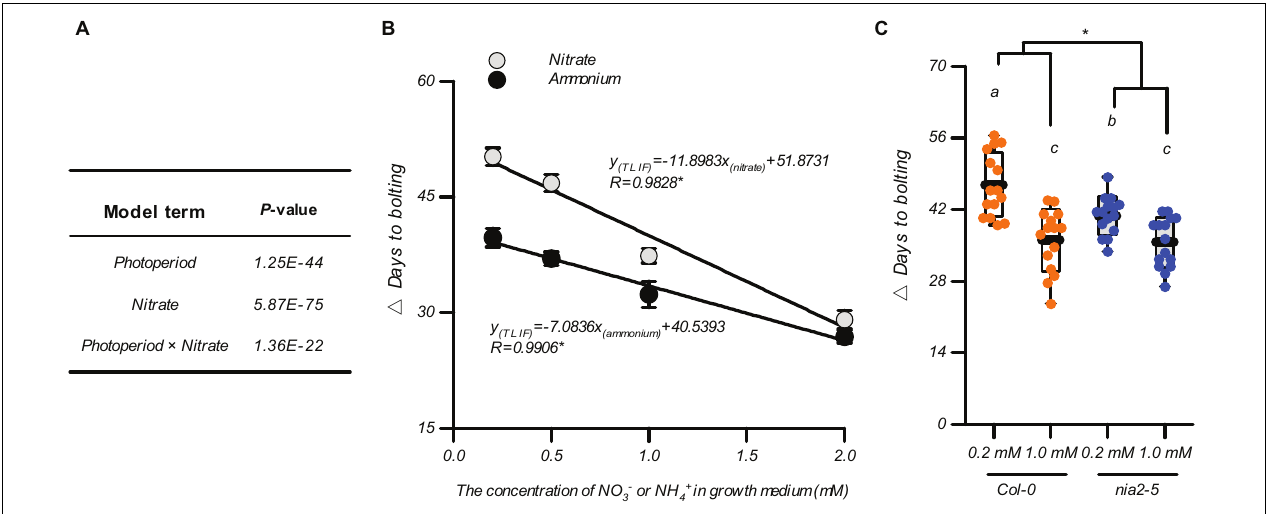
FIGURE 2 | Association of flowering under LD conditions with nitrate availability. (A) Statistical analysis of the data from Figures 1A,C . Data were analyzed using a two-way ANOVA followed by Duncan’s multiple range test. (B) The time of LD-induced flowering ( (cid:77) days to bolting) in the Col-0 plants grown with different nitrogen sources. Different concentrations of (NH 4 ) 2 SO 4 including 0.2, 0.5, 1.0, and 2.0 mM were used to replace the KNO 3 in the agar medium. (C) The time of LD-induced flowering ( (cid:77) days to flowering) in the Col-0 plants and nia2-5 mutants, grown with 0.2 mM or 1 mM nitrate. Seedlings were grown on agar media containing nitrate or ammonium as indicated. The potassium concentrations in all growth media were adjusted to 1 mM using K 2 SO 4 . LD: 16-h light/8-h dark; SD: 8-h light/16-h dark. (cid:77) Days to bolting was calculated by subtracting the bolting time of plants grown under LD conditions from that of plants grown under SD conditions, with the same nitrogen treatment. Raw data of panels (B,C) from individual photoperiods are shown in Supplementary Figures 6, 7 . At least 20 plants grown in each of the LD and SD conditions were used for the quantification of flowering. Error bars represent ± standard deviations. Different letters indicate significant differences between means, as determined using a two-way ANOVA followed by Tukey’s multiple comparisons test ( P < 0.05). Asterisk indicates significant interaction of photoperiod × nitrogen source (B) or photoperiod × genotype (C) at P < 0.05 (two-way ANOVA).